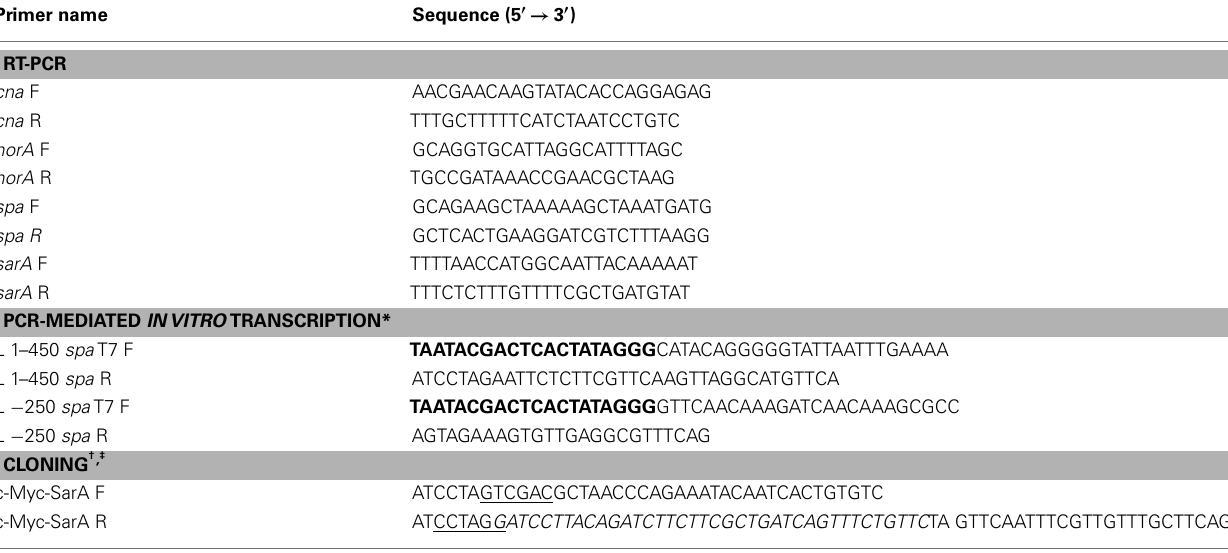
Table 2 | Oligonucleotides used in this